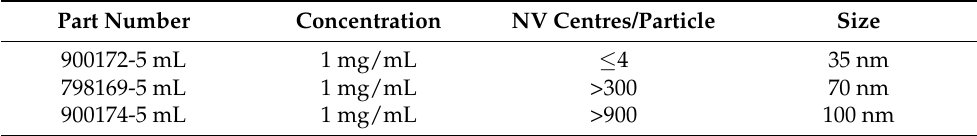
Table 1. Sigma Aldrich’s nanodiamonds